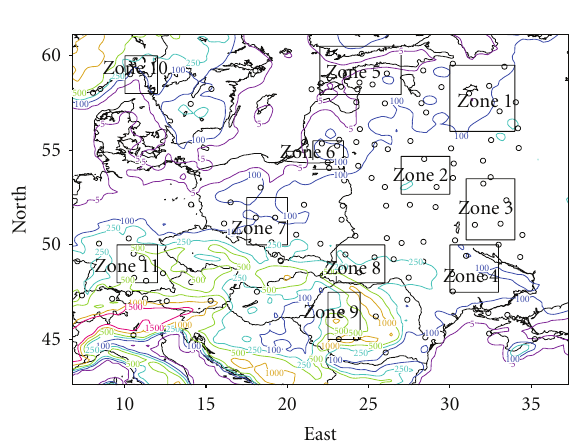
Figure 1: Model chosen domain along with the topography. The circles indicate the available station observation over the domain during 1–31 January 2006. The boxes indicate di ff erent zones chosen for